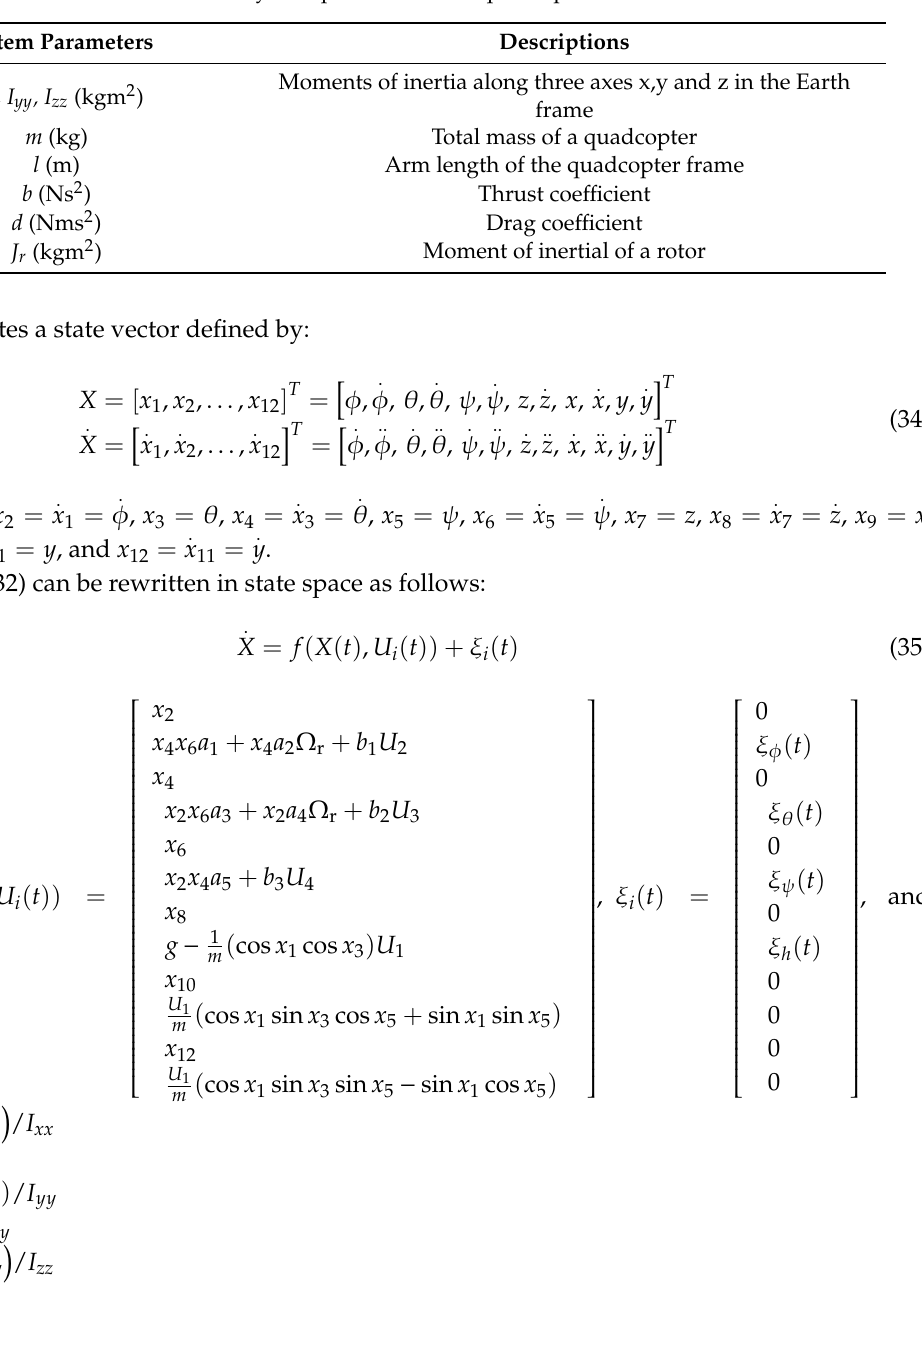
Table 1. System parameters of a